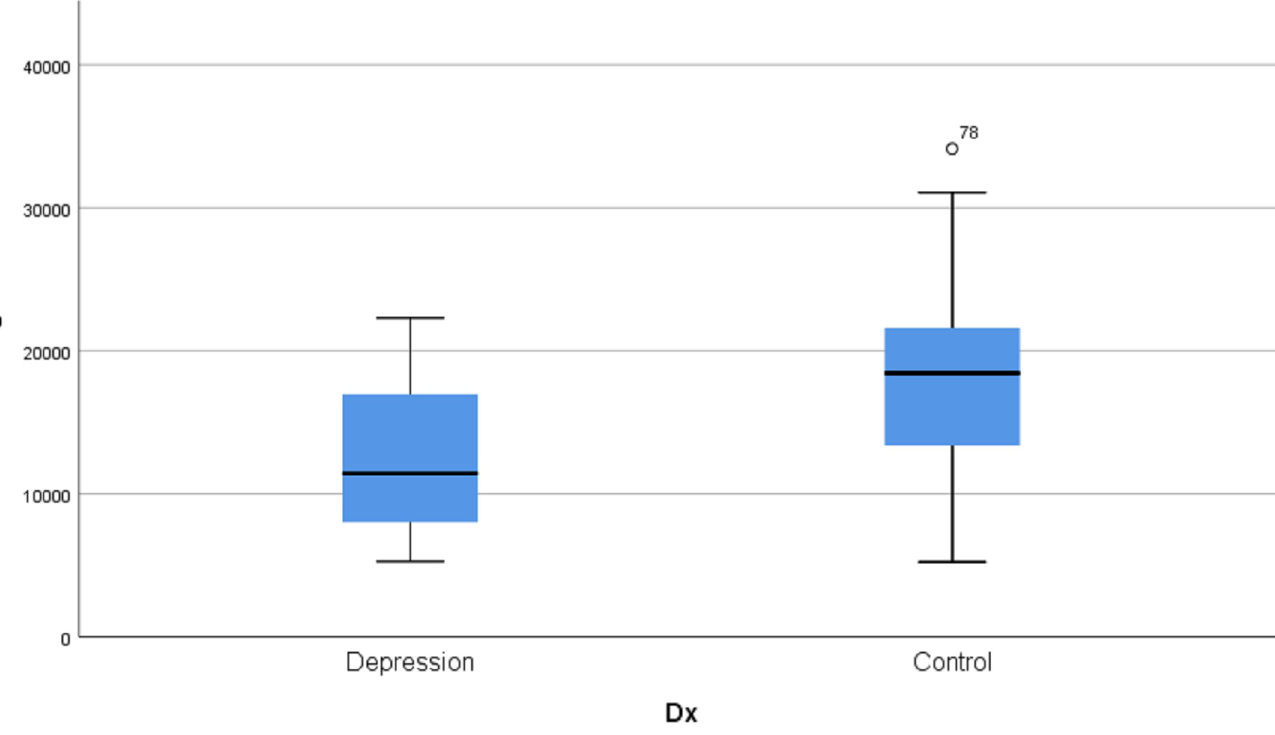
PLOS ONE | https://doi.org/10.1371/journal.pone.0251026 May 6,